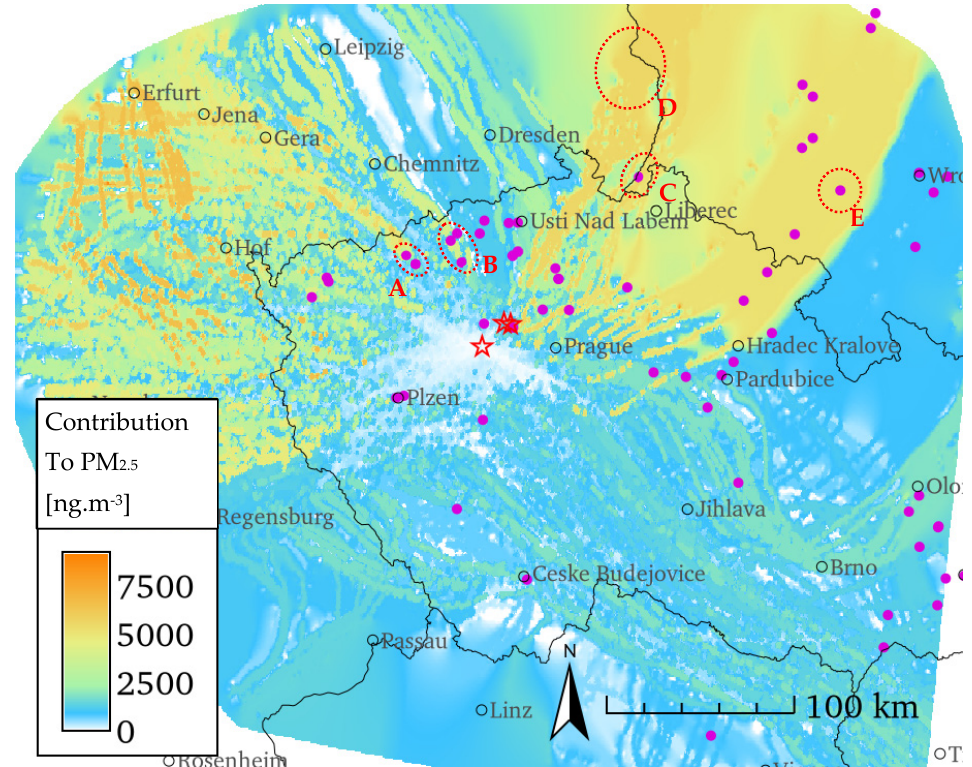
Figure 7. Visualization of batch-processed back trajectories for the other sulfates factor. Dashed red lines delimit potential sources: A—Prun é ˇrov and Tušimice power plants; B—Poˇcerady and Komoˇrany power plants and Unipetrol RPA chemical installation; C—Tur ó w power plant; D—Jänschwalde, Boxberg, and Schwarze Pumpe power plants; E—Polski Koncern Naftowy ORLEN S.A. oil